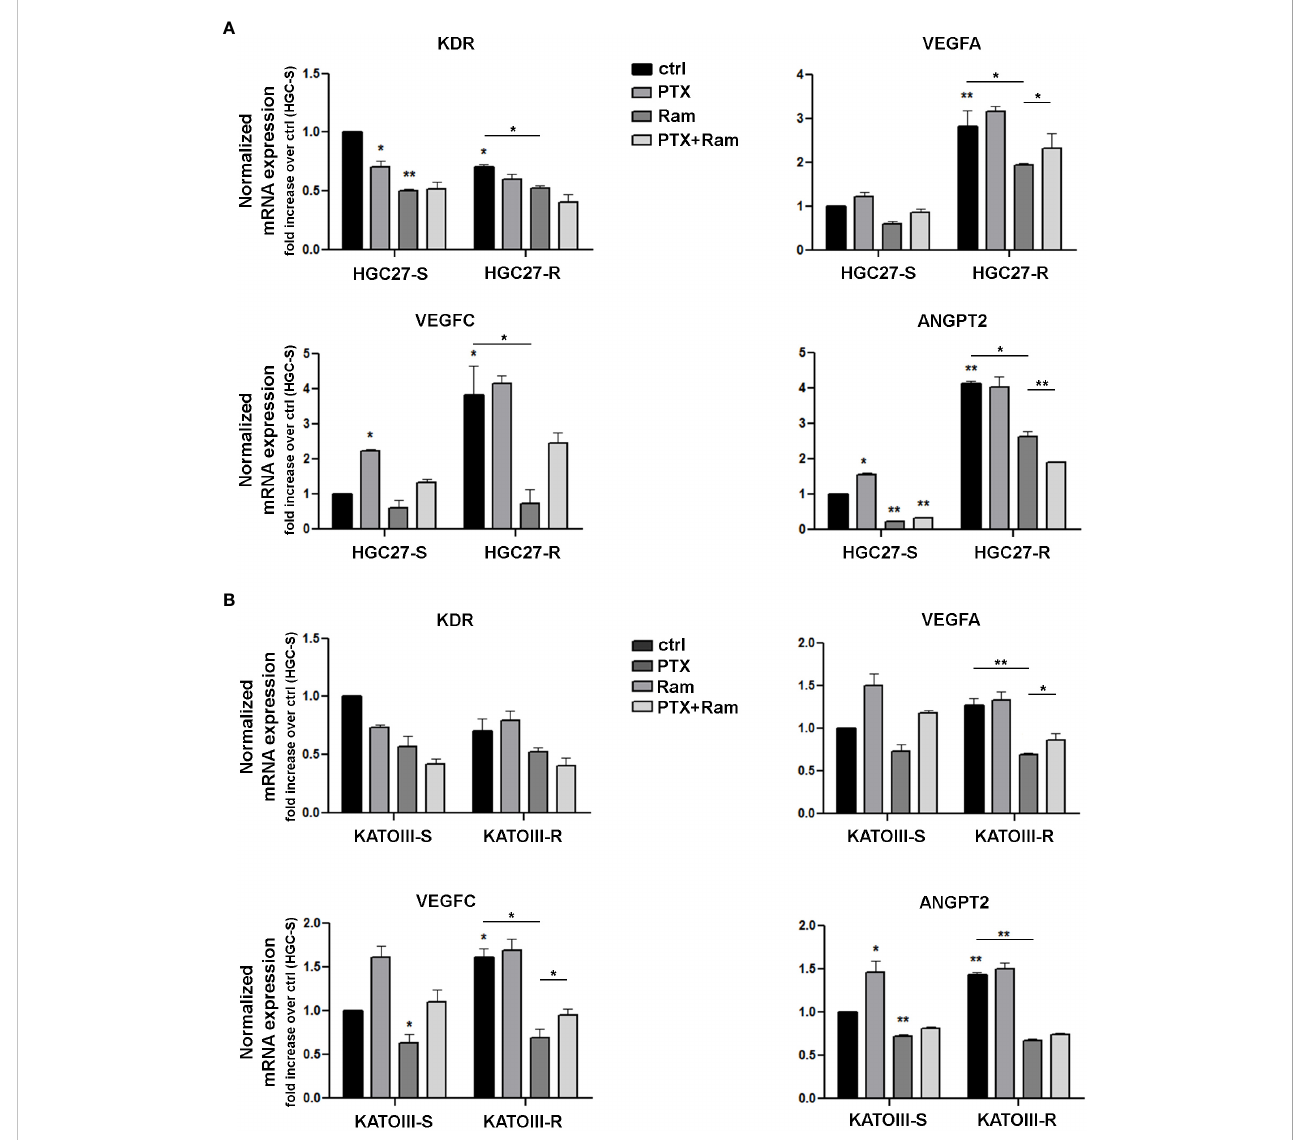
FIGURE 1 Real time PCR experiments in HGC27-S/R (A) and KATOIII-S/R (B) with speci fi c primers for KDR, VEGFA, VEGFC, ANGPT2 genes. The mRNA expression was normalized on GAPDH housekeeping gene. Expression analysis performed after treatment with 4 nM PTX (HGC27) or 2 nM PTX (KATOIII) and 100 mg/mL Ramucirumab administered individually or in combination for 24 hrs. All expression values were calculated against the value of untreated PTXsensitive cells, fi xed at 1. Statistical analysis was assessed comparing the values obtained using single drug treatment to those of corresponding untreated cells and the combined treatments to those of single treatments. The values of untreated PTX-resistant cells were compared with those of untreated PTX-sensitive ones. Data were mean ± SD (n=3). *p<0.05,